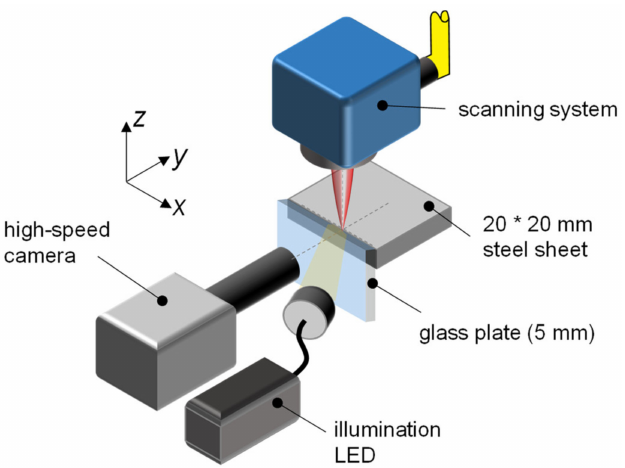
Figure 1. Schematic depiction of the experimental setup for high-speed recordings in the half- section